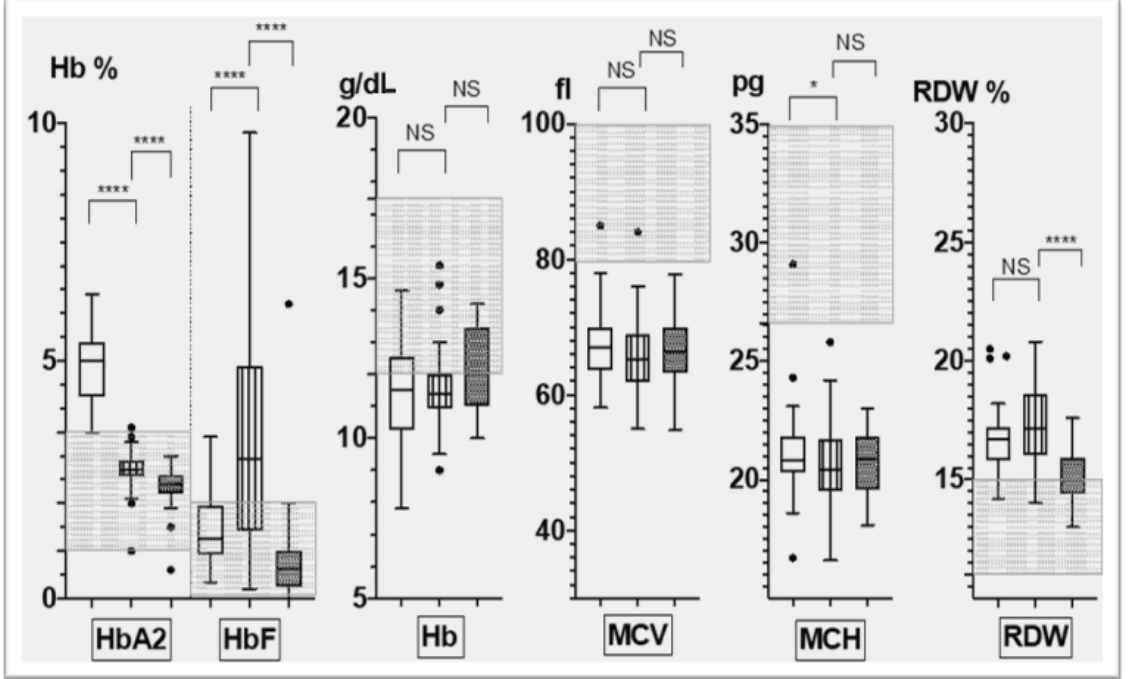
Figure 2. Tukey’s plots representing relevant parameters of hematological phenotypes in 50 Corfu δ ο β + heterozygote (boxplots with lines), 58 with IVSI-110 variant (plain boxplots) and 45 with α 0 deletion thalassemia (dotted boxplots). The upper whisker span represents the 75th percentile plus 1.5 times the interquartile distance and the lower the 25th percentile minus 1.5 times the interquartile distance. Dots represent individual values falling beyond the whiskers. Shaded areas correspond to normal range. NS: Non Significant/* p < 0.05. ** p < 0.01, *** p < 0.001 and **** p < 0.0001.